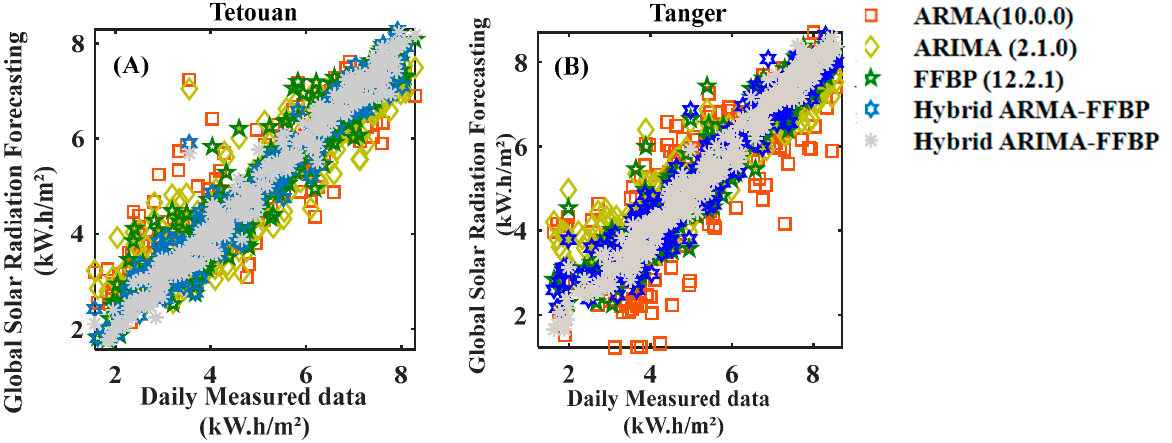
Figure 13. ( A , B ) Correlation coefficient (R 2 ) of daily GSR vs. measured data of best five models (regression plot).